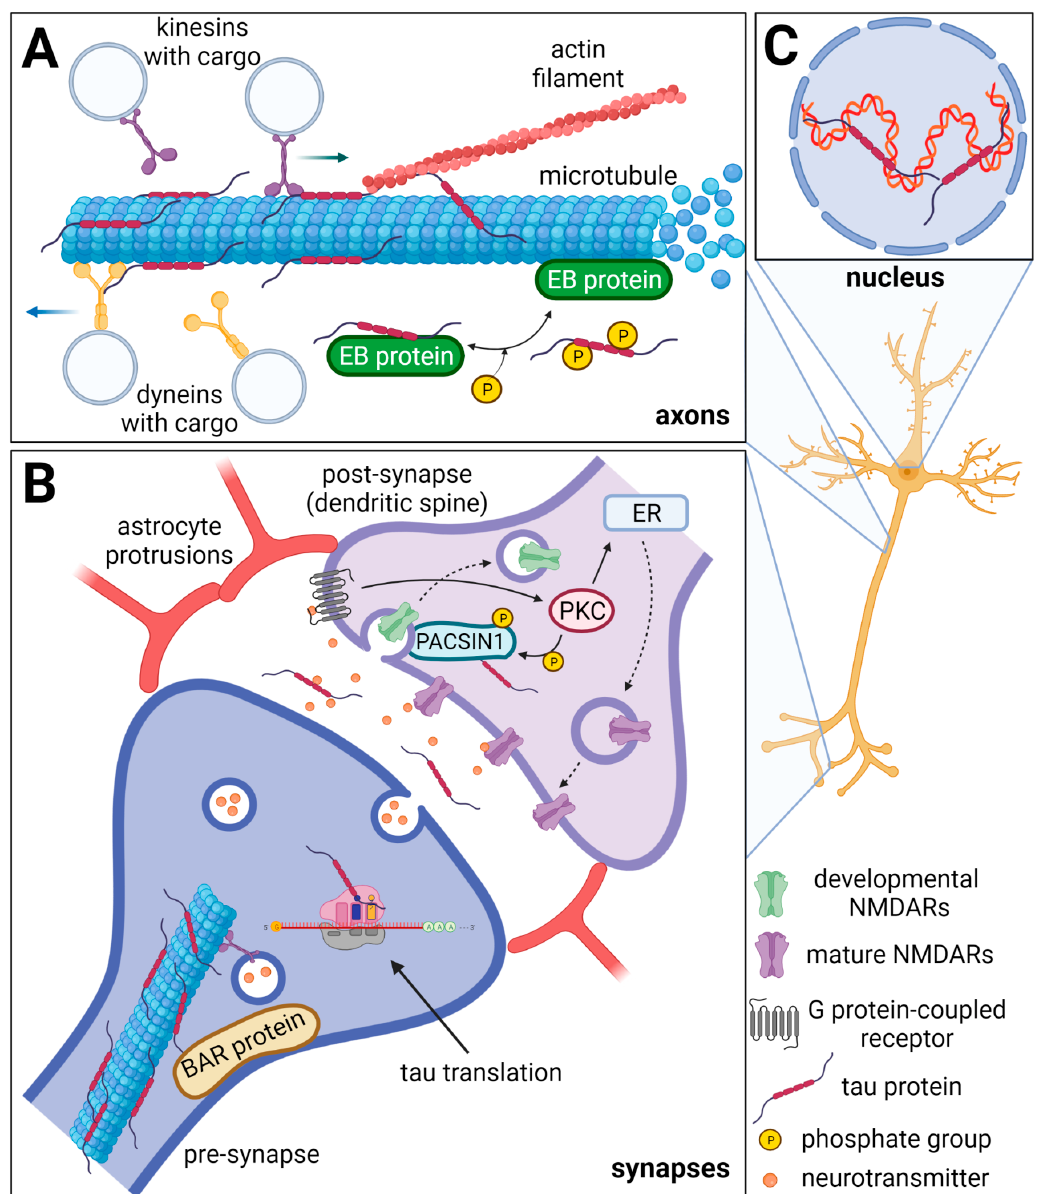
Figure 1. Schematic representation of physiological tau protein functions in neurons. The axonal tau ( A ) stabilizes microtubules (MTs), and it can also bind actin filaments thus facilitating cytoskeleton networking. Furthermore, tau regulates MT dynamics by interacting with end-binding (EB) proteins. The EB proteins promote and regulate MT nucleation and elongation. Tau inhibits the EB protein binding to MTs and this inhibition is reversed by tau phosphorylation. Tau also competitively inhibits the interaction of dynein and kinesin to MTs and thus influences the intraneuronal transport and cargo release. In the synapses ( B ), tau protein can be directly translated, and during neuronal activity, it is released into the synaptic cleft. Through linking the MTs and actin filaments, tau can influence synaptic plasticity. Moreover, tau is a known interacting partner of the BAR domain-containing proteins such as BAIAP2, PACSIN1, and BIN1, that ensure the curvature and shaping of the neuronal membrane. Tau may play a role in the removal of developmental NMDARs and their replacement for mature NMDARs in dendrites (dashed arrows) as it is a known substrate of the protein kinase C (PKC), which is activated by the G protein-coupled receptors (GPCR). The PACSIN1 recruits clathrin and dynamin endocytic machinery to the developmental NMDARs and thus mediates their removal. The developmental/mature NMDARs exchange is important for the formation of new synaptic connections. ER—endoplasmic reticulum. In the nucleus ( C ), tau interacts with DNA and RNA, maintains their integrity, and protects them from oxidative damage. Furthermore, tau may be involved in rRNA-coding DNA transcription and rRNA processing. Created with